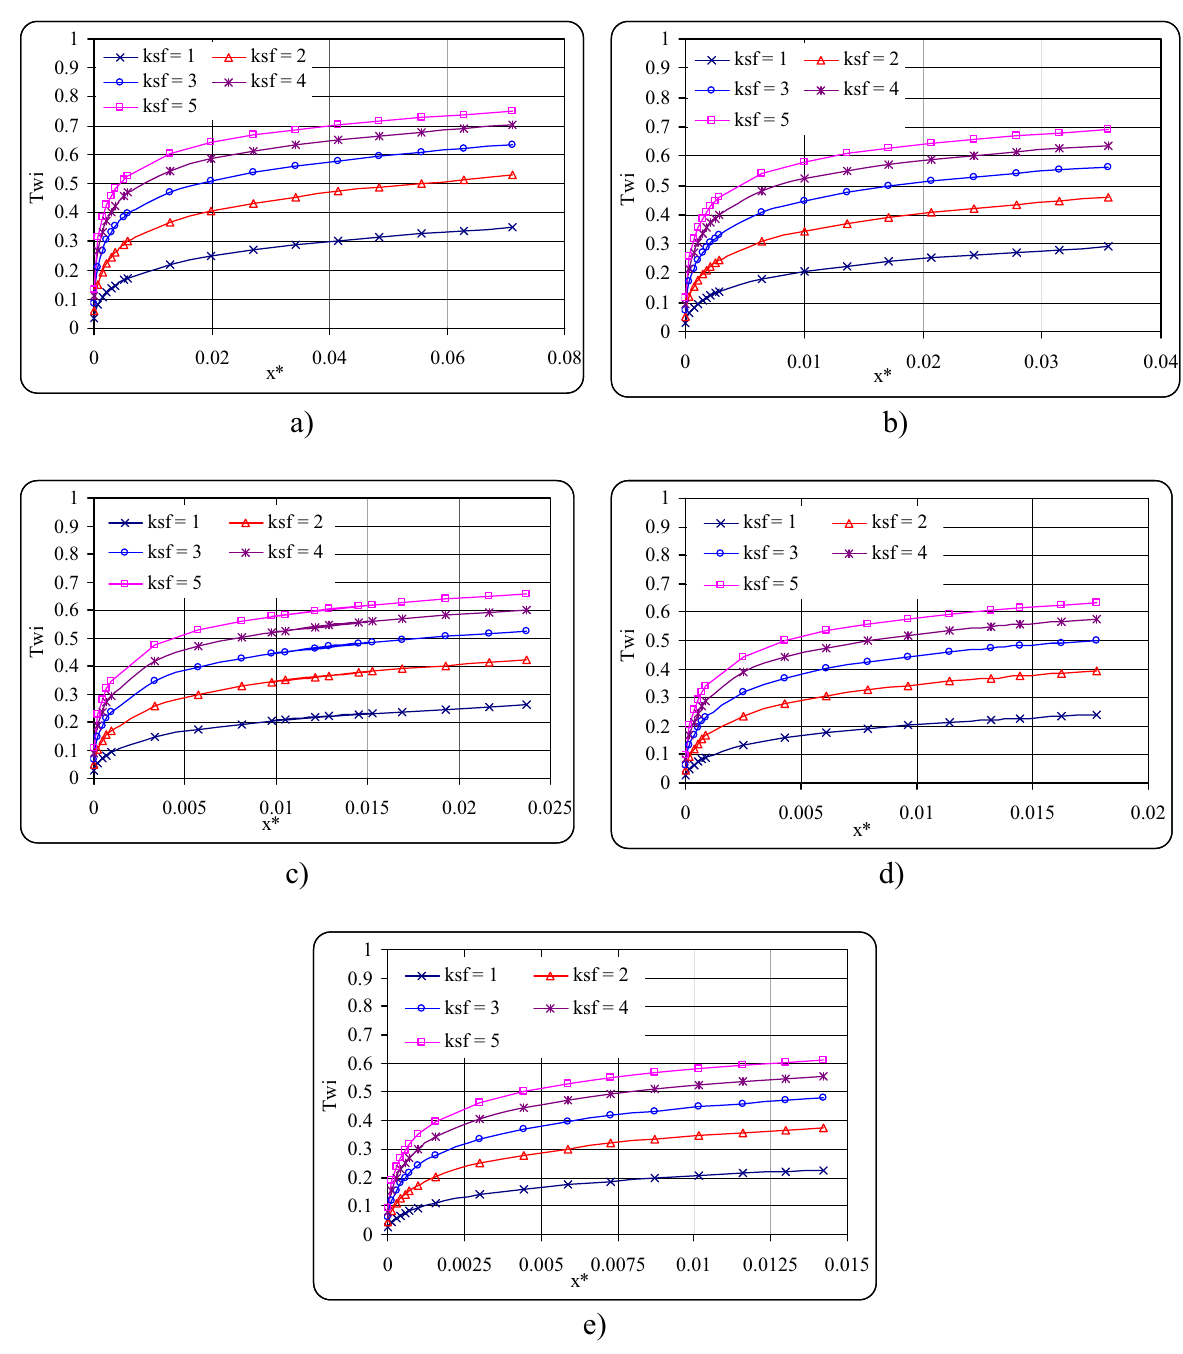
Figure 8: Relationship between dimensionless inside wall temperature vs dimensionless axial coordinate δ /R i = 1.5 and Pr = 7, with variable ksf ratio. ( a ) Re = 200, ( b ) Re = 400, ( c ) Re = 600, ( d ) Re = 800, and ( e ) Re =